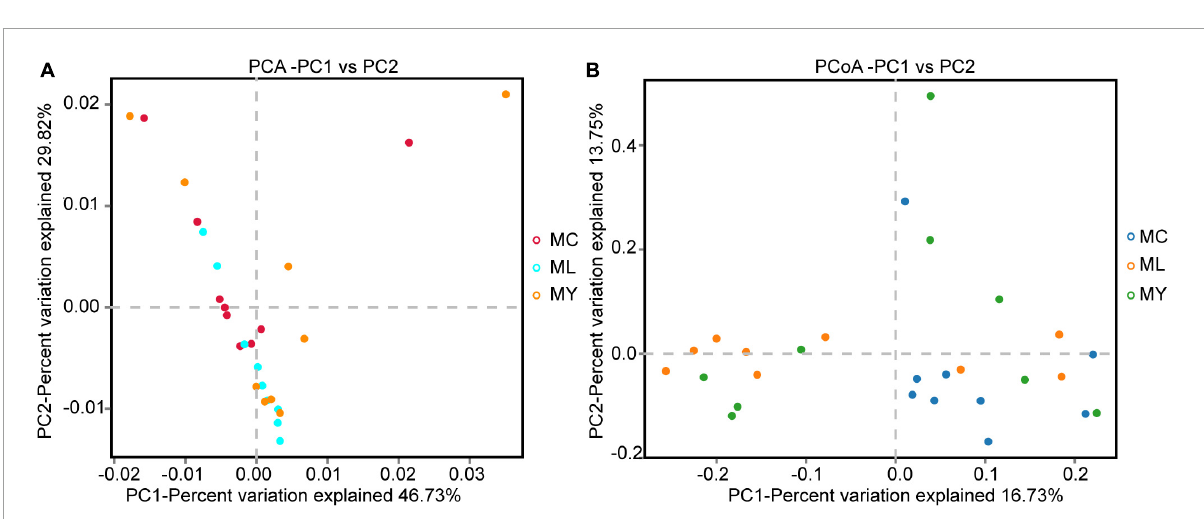
( Supplementary Table 4 ). The only differential metabolite common to all three groups was N-acetylhistamine.